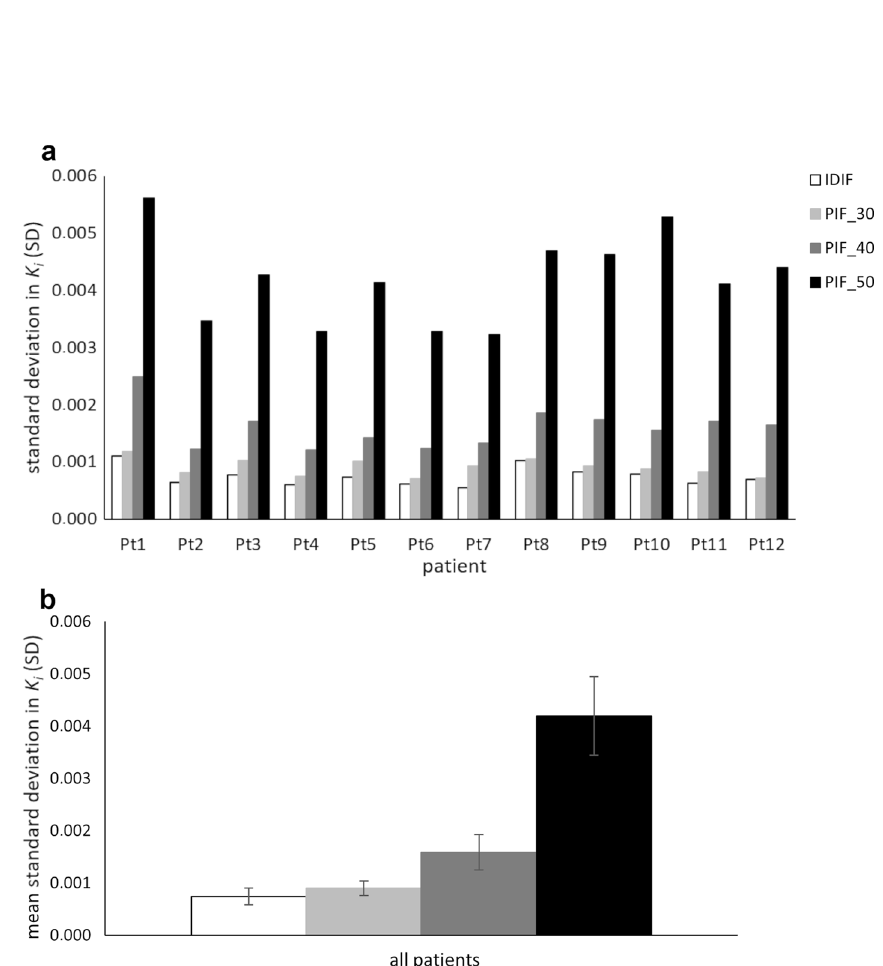
Table 2 Healthy tissue K